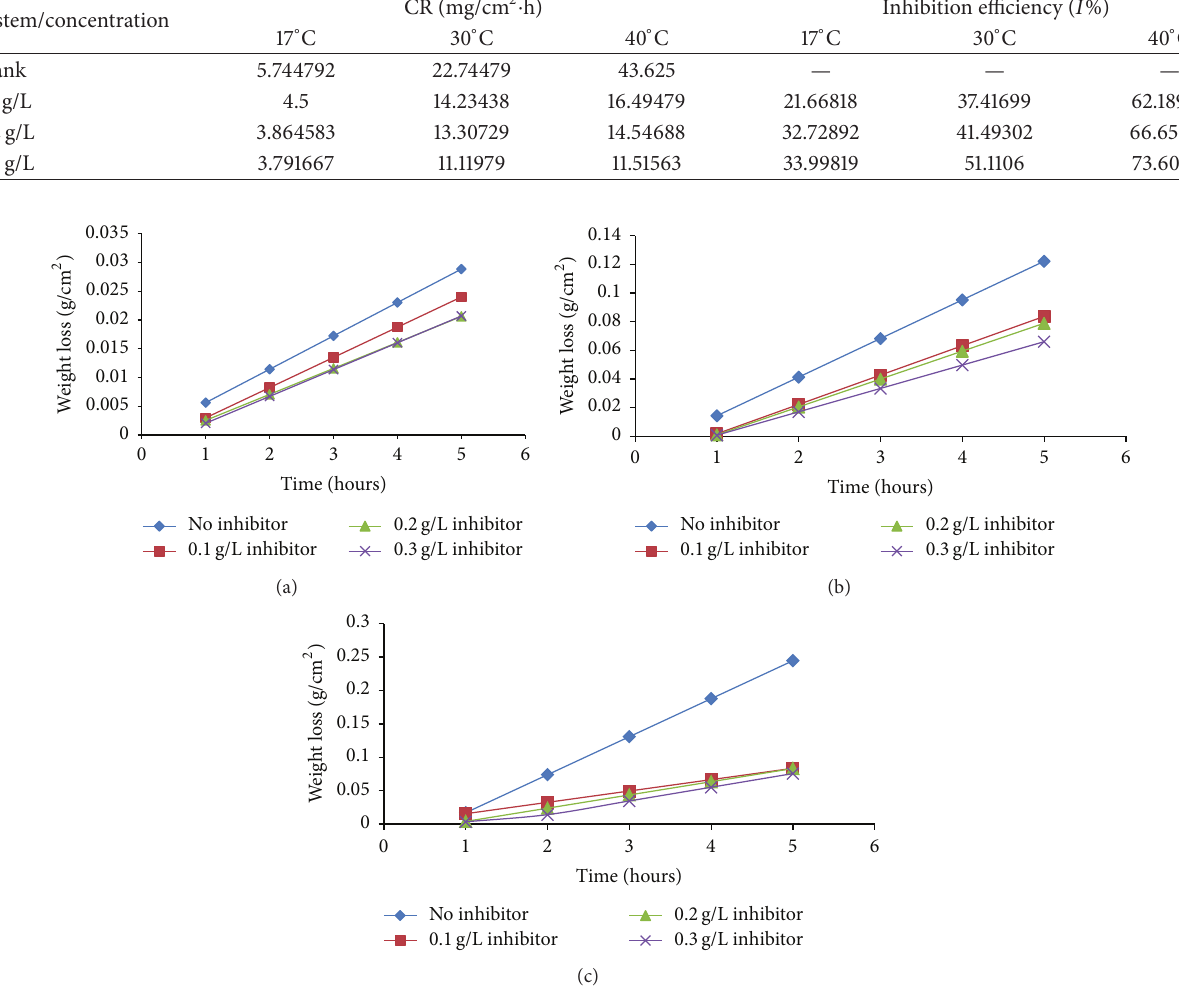
Figure 2: Weight loss of mild steel versus time (hours) in 1M hydrochloric acid in the absence and presence of natural polymer at (a) 17 ∘ C, (b) 30 ∘ C, and (c) 40 ∘